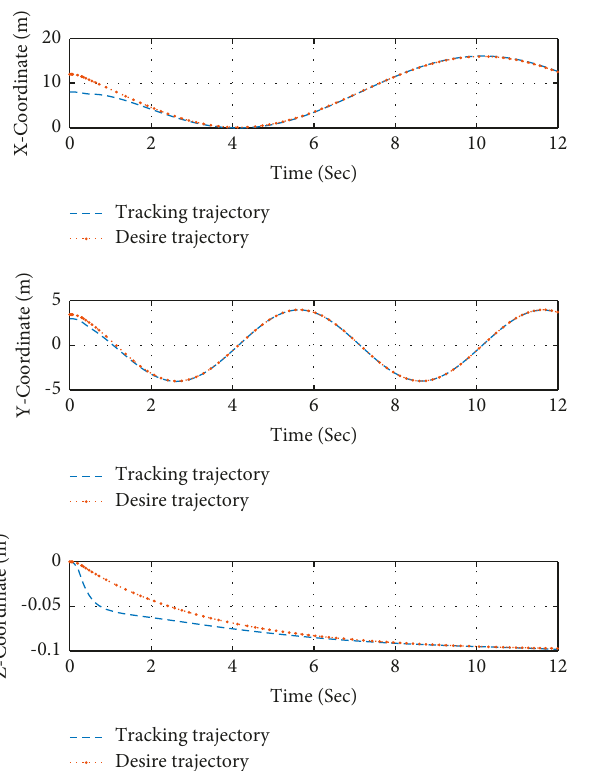
Figure 10: The resault of tracking desire trajectory in 2D.